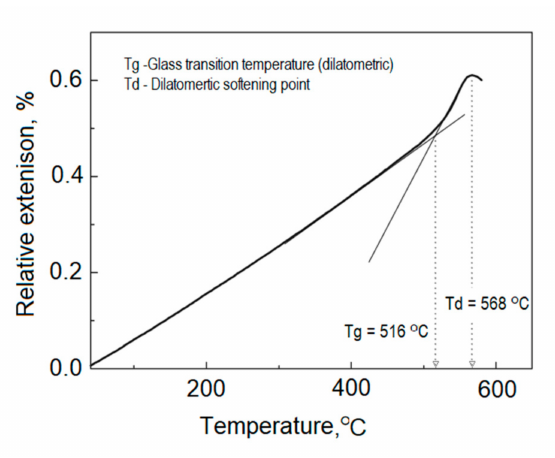
Figure 3. Measurement of Tg using